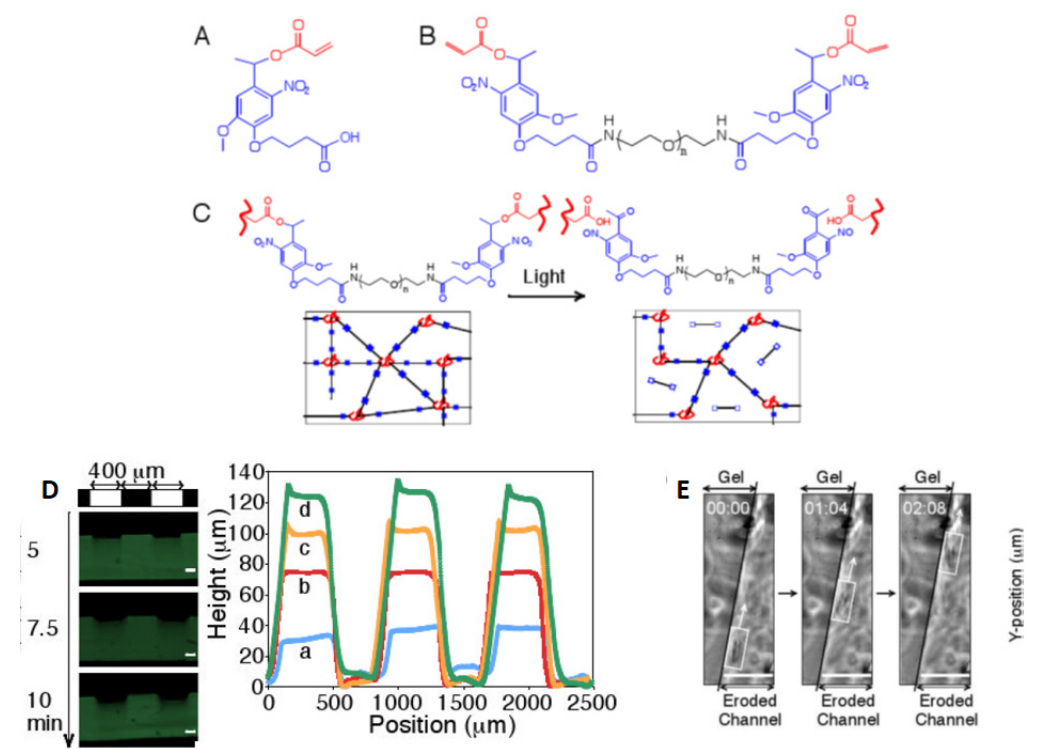
Figure 5. Panels A–C: ( A ) base photodegradable acrylic monomer used to synthesize ( B ) the photodegradable cross-linking macromer (Compound B, Mn ∼ 4070 g/mol), comprising PEG (black), photolabile moieties (blue), and acrylic end groups (red). ( C ) Compound B was copolymerized with PEGA (Mn ∼ 375 g/mol), creating gels composed of poly(acrylate) chains (red coils) connected by PEG (black lines) with photolabile groups (solid blue boxes). ( D ): Thick gel surface erosion induced by irradiation (left; scale bar, 100 µ m). The gel, covalently labeled with fluorescein, was eroded spatially via masked flood irradiation (320–500 nm at 40 mW/cm 2 ). Channel depth, quantified with profilometry, increased linearly with irradiation time: (a) 2.5, (b) 5, (c) 7.5, and (d) 10 min (right). ( E ): Channels were eroded within a hydrogel encapsulating fibrosarcoma cells, releasing cells into the degraded channel and enabling migration. Migration of a cell along the edge of a channel is shown in time-lapsed brightfield images. Scale bar, 50 µ m. Adapted and reprinted with permission from